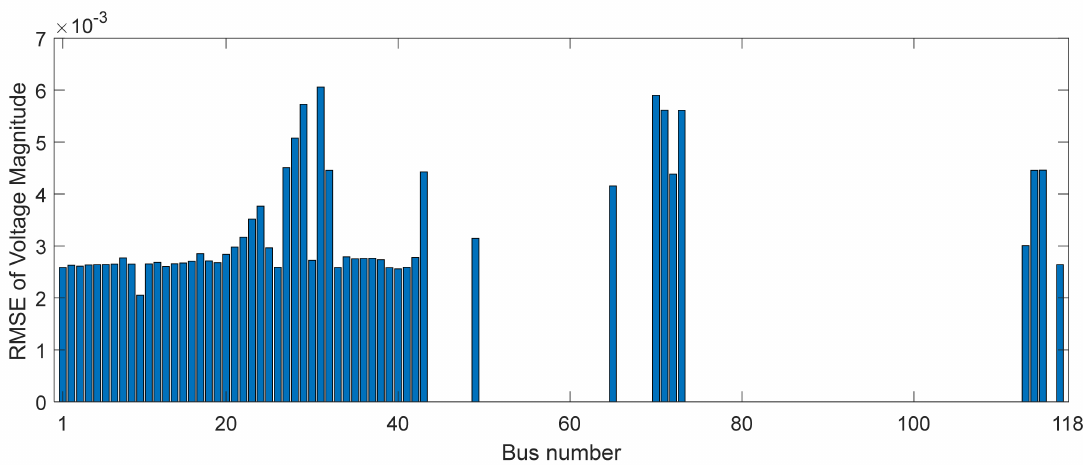
Figure 9. RMSE of bus voltage magnitude with bus-to-ground fault at bus 30.